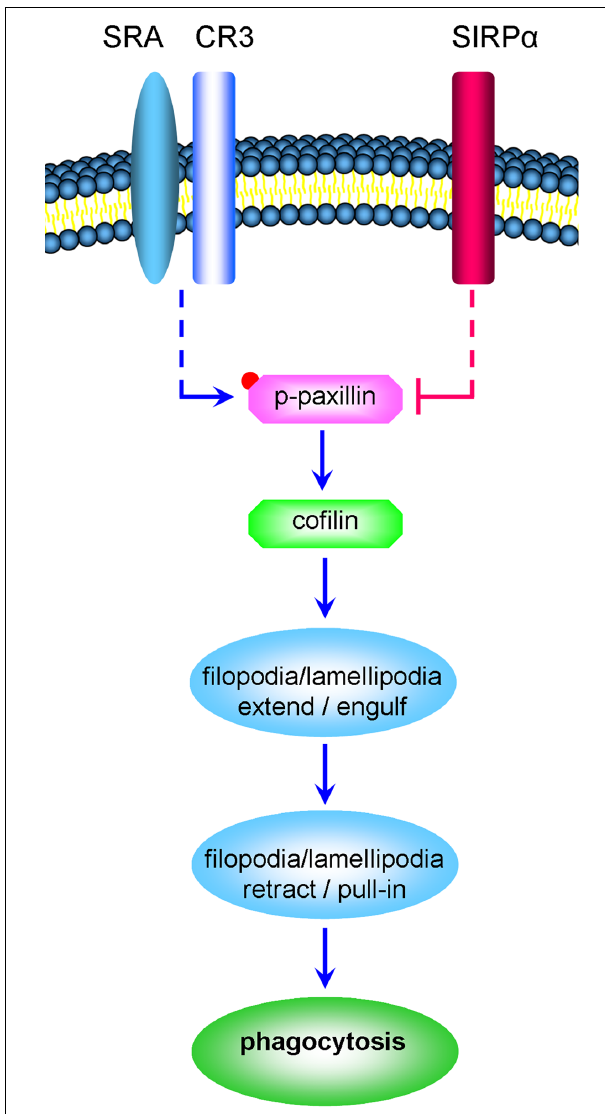
FIGURE 1 | CR3 and SRA advance the phagocytosis of degenerated myelin by promoting the activation of paxillin and cofilin whereas SIRP α inhibits phagocytosis by promoting the inactivation of paxillin and cofilin (a schematic representation of the working hypothesis). Degenerated myelin ligates simultaneously phagocytic receptors CR3 and SRA and immune inhibitory receptor SIRP α . CR3 and SRA produce the signaling that culminates in structural changes (marked by ellipses); filopodia and lamellipodia first engulf the myelin-debris as they extend and then pull-in the myelin-debris as they retract.We hypothesize the following. Phagocytic receptors promote paxillin activation through phosphorylation (paxillin → p-paxillin) leading to cofilin activation through dephosphorylation (p-cofilin → cofilin). In turn, cofilin promotes the production of filopodia and lamellipodia and so phagocytosis is advanced. In contrast, SIRP α promotes the inactivation of paxillin through p-paxillin dephosphorylation (p-paxillin → paxillin) leading to cofilin inactivation through phosphorylation (cofilin → p-cofilin). In turn, the production of filopodia and lamellipodia is reduced and so phagocytosis is inhibited. Retraction of filopodia and lamellipodia is promoted by MLCK triggering motor activity in non-muscle-myosin which then initiates F-actin/non-muscle-myosin-based contraction (not illustrated). Dashed lines mark indirect interactions; blue lines mark activation and red lines inhibition of